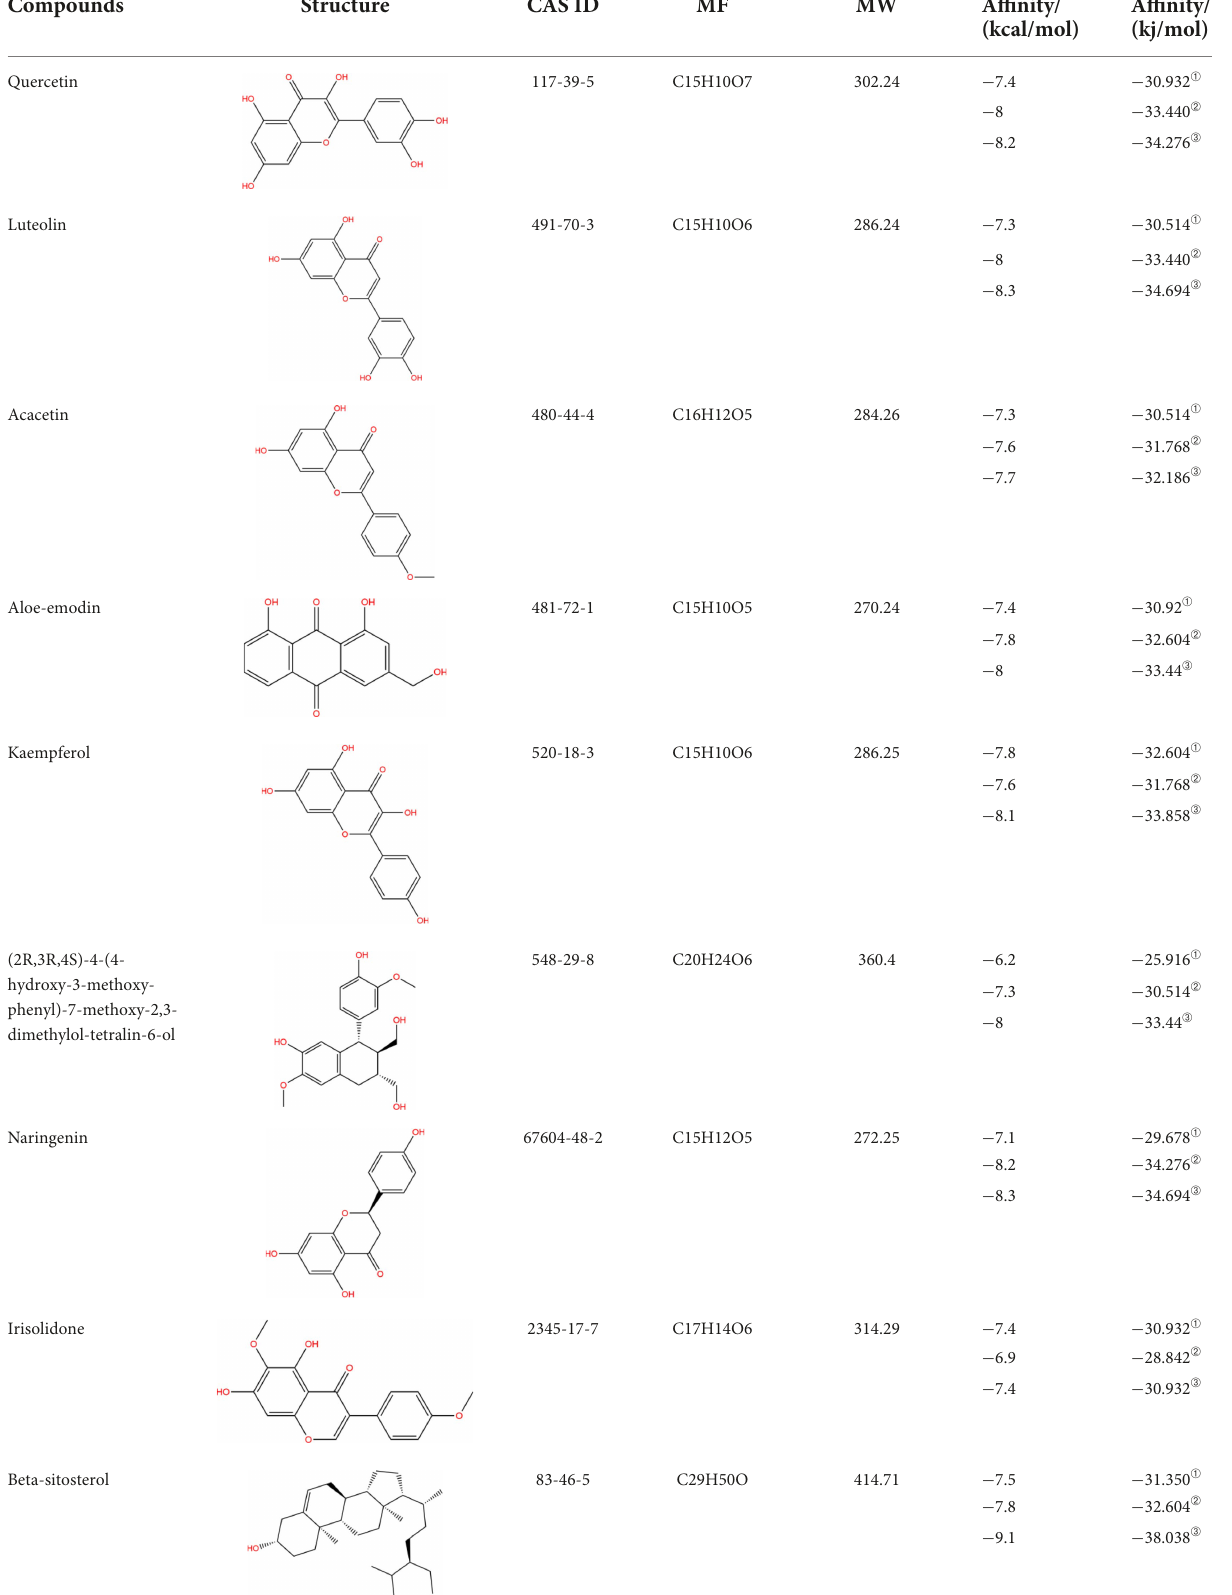
TABLE 7 Chemical information and binding energy of four CPM main potential active ingredients and antiviral drugs. Compounds Structure